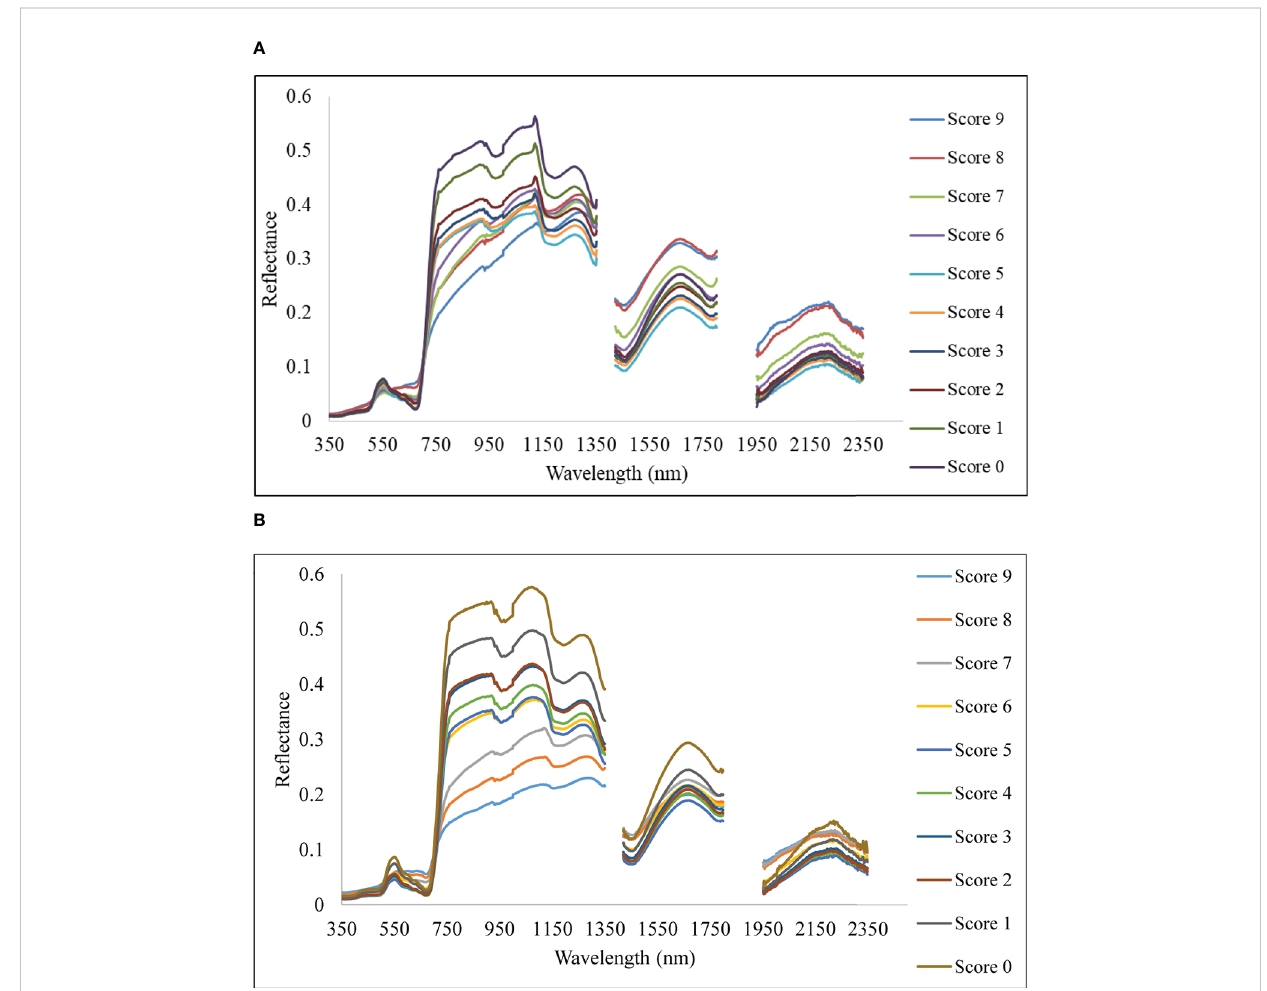
FIGURE 4 Spectral re fl ectance of rice canopy under different disease severity levels. (A) Upland and (B) lowland